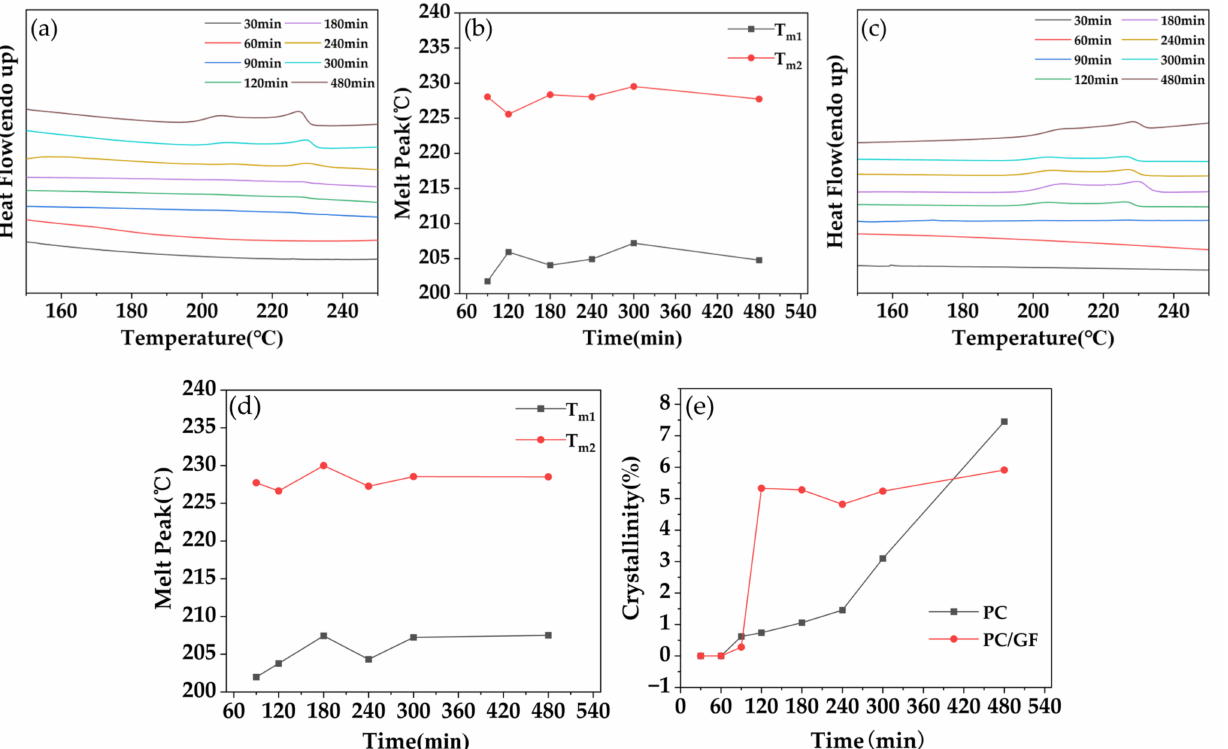
Figure 4. ( a , b ) DSC plots and melt peak variation plots of PC, ( c , d ) DSC plots and melt peak variation plots of PC/GF15, ( e ) variation plots of crystallinity of PC and